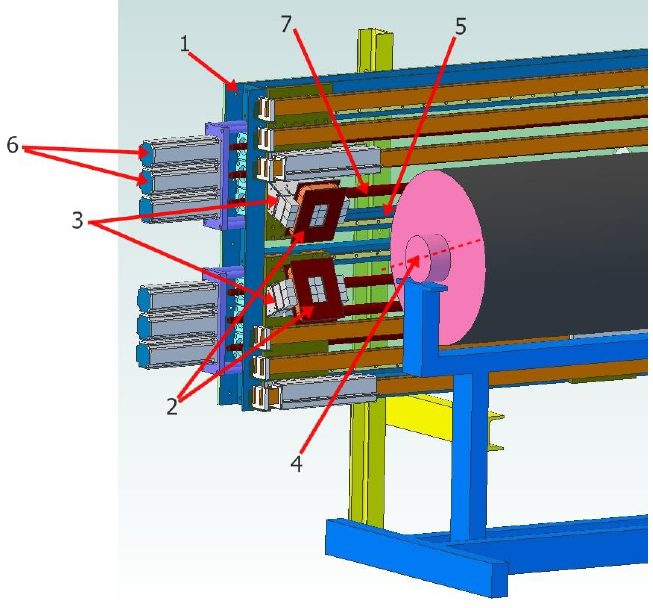
Figure 3. Schema of the motive system of the inductors along the axis of the cylinder.